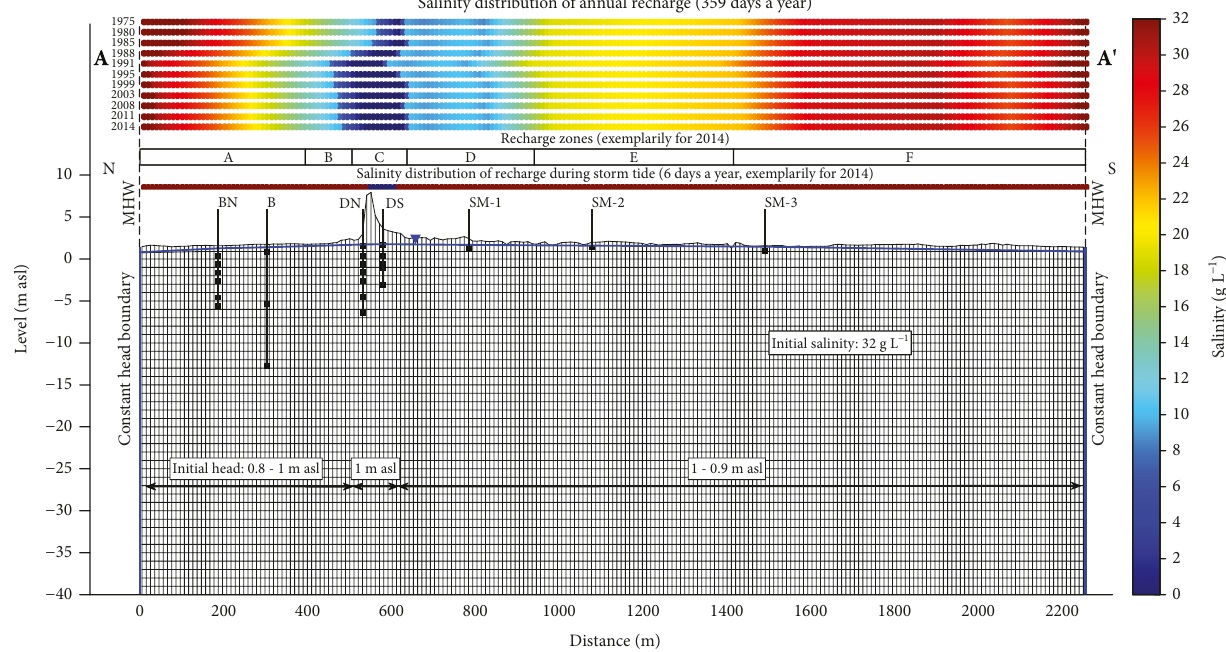
Figure 3: Model set-up of the north-south oriented cross-section A-A ’ (Figure 1) with initial and boundary conditions. Fresh recharge areas indicate variations of the position and extent of the elevated dune area for the depicted years considered in the VG-model. Between these years, the recharge salinity of the previous year was assigned. In the CG- and CGWST-model, the salinity distribution of 2014 was kept constant. Salinities are indicated by the color scale (this also applies to the following fi gures). Zones A-F represent zones of di ff erent recharge rates kept constant in the CG- and CGWST-model. In the VG-model, zones depended on the geomorphology of the respective year. Table 1: Overview of model parameters. Parameters marked with ( ∗ ) were calibration parameters. Hydraulic conductivity, porosity, and longitudinal and vertical transverse dispersivities were set constant across the model domain, i.e., homogeneity of the porous medium was assumed.